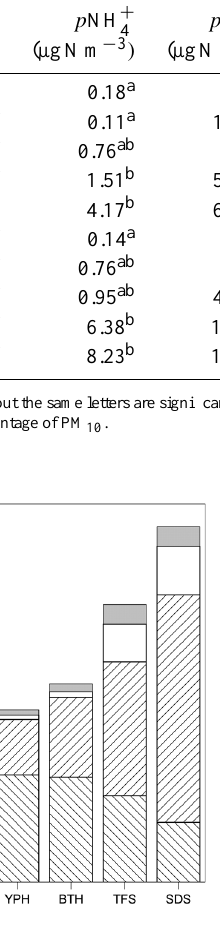
Table 2. Concentrations of PM 10 , p NH + p NO − ) to PM 10 . 3